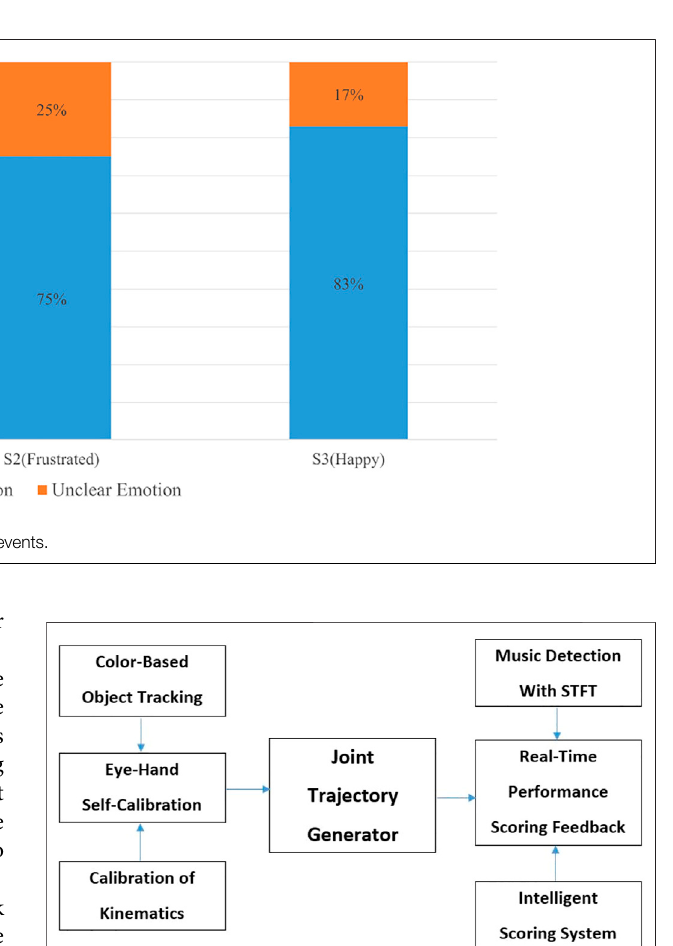
FIGURE 6 | Block diagram of Module-based acoustic music interactive